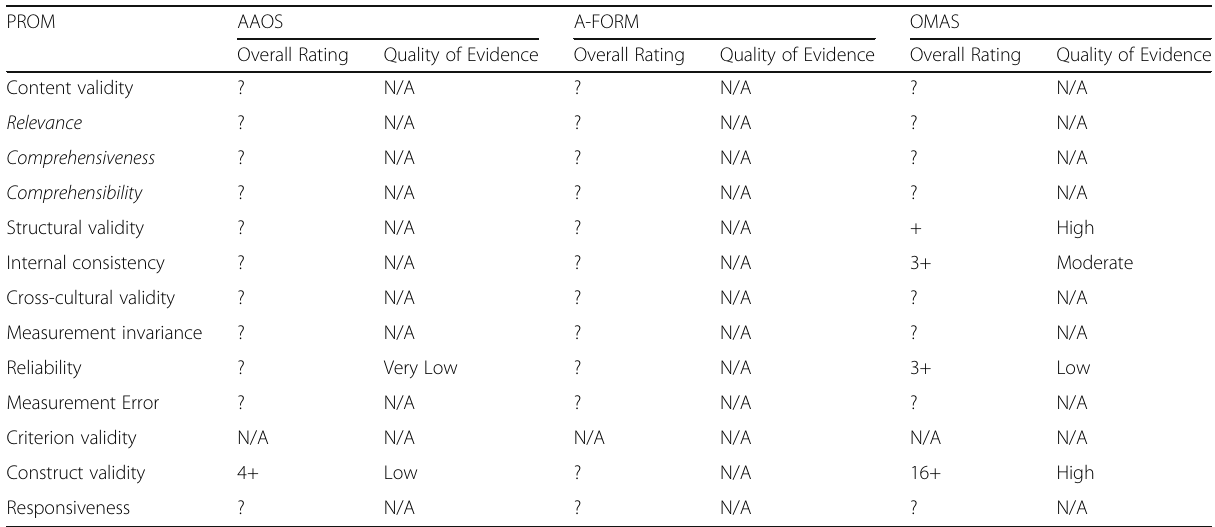
Table 6 Summary of findings